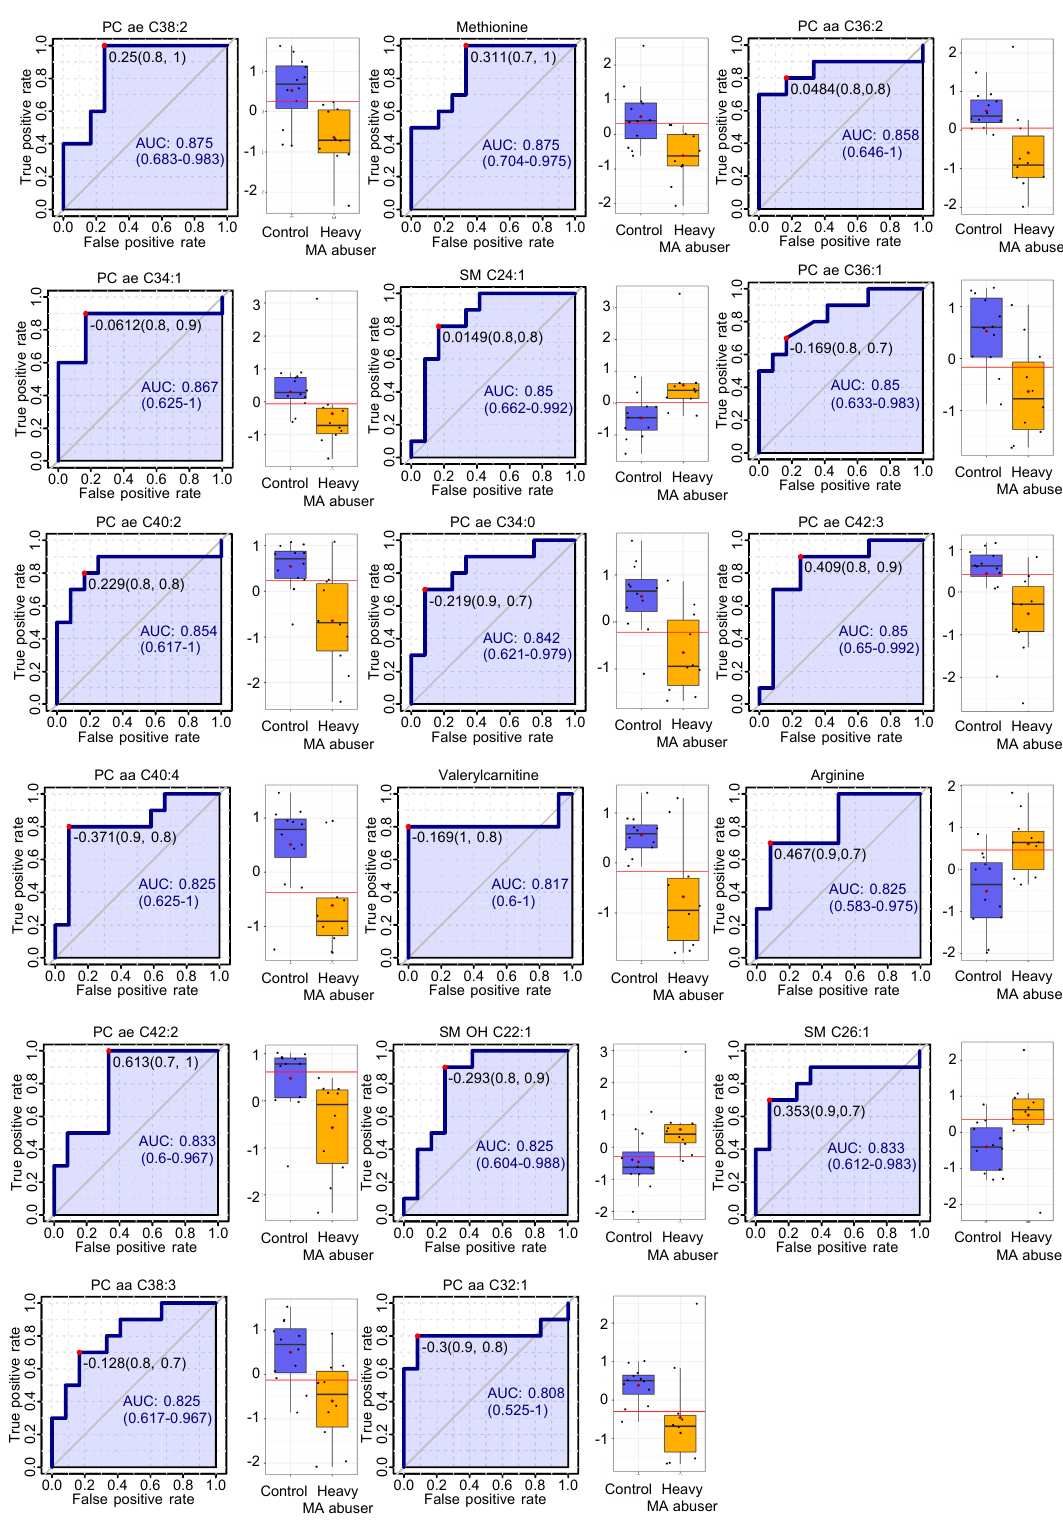
Figure 2. Results of the receiver operating characteristic (ROC) curve analysis of the 37 metabolites from t -test, variable importance on projection scores, and ROC curves in targeted metabolomics and metabolite levels. AUC: area under the ROC curve.